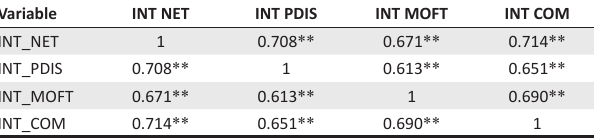
TABLE 4: Revised Interaction meta-competency bivariate correlations.